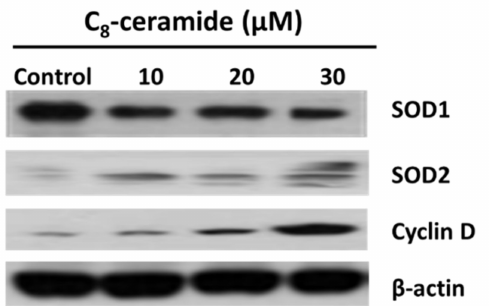
Figure 6. Regulation of SOD1/2 and cyclin D1 proteins induced by C 8 -ceramide. After C 8 -ceramide treatment, SOD1 downregulation may be controlled by ROS, which can negative feedback to SOD1 switched SOD2 and then modulated the expression of cyclin D1. β -actin as an internal